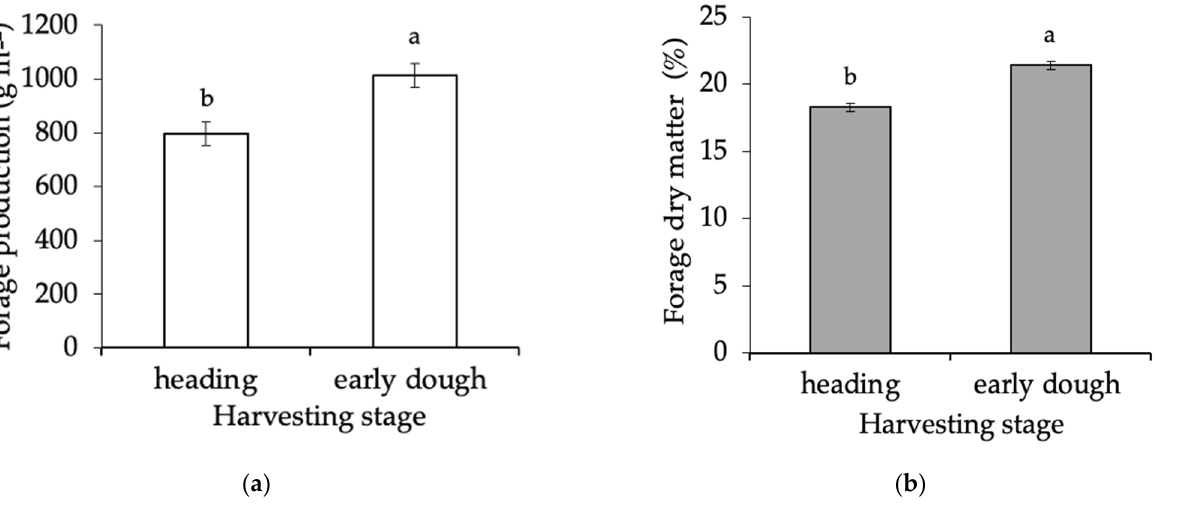
Figure 10. Harvesting stage main effect on ( a ) forage production and ( b ) forage dry matter concentration. Values are means of two years, two cropping systems, five N rates, and three replicates. Vertical lines represent HSD and values with the same letter are not statistically different for p ≤ 0.05.